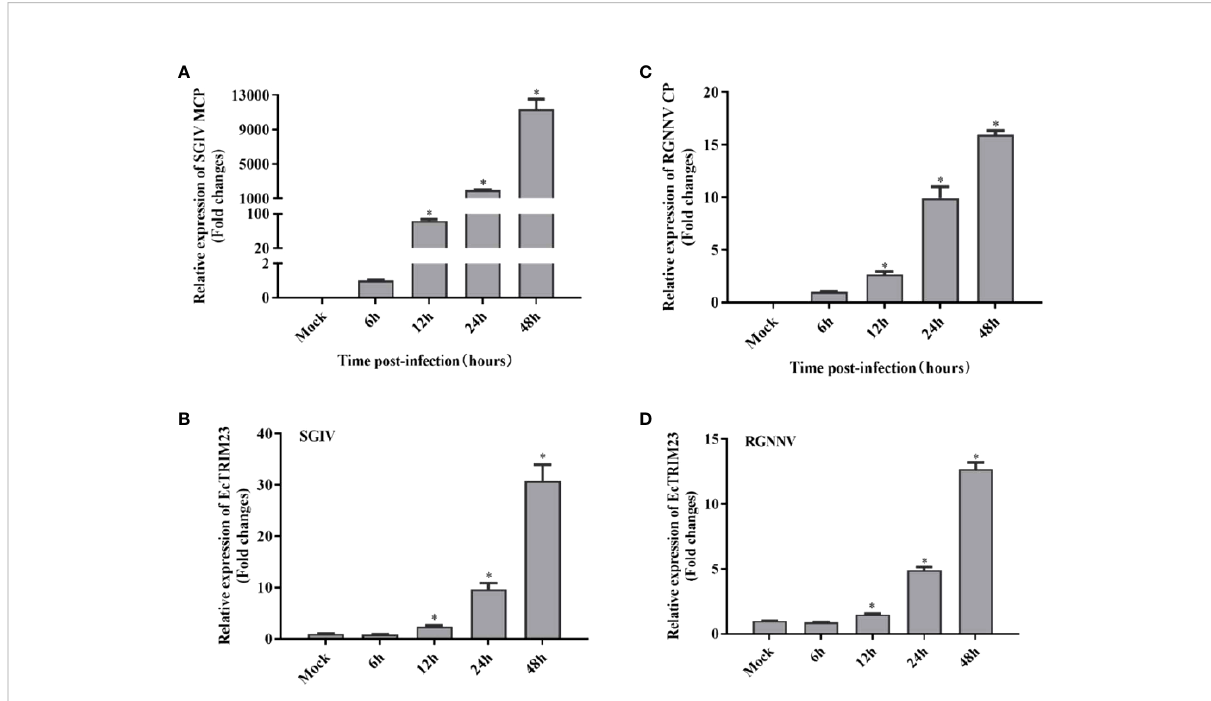
FIGURE 2 Expression pro fi les of EcTRIM23 during virus infection. In SGIV or RGNNV infected cells, SGIV MCP (A) , RGNNV CP (B) and EcTRIM23 (C, D) were detected by qPCR. GS cells were infected with SGIV or RGNNV, and then collected at the indicated time points for qPCR examination. *p <